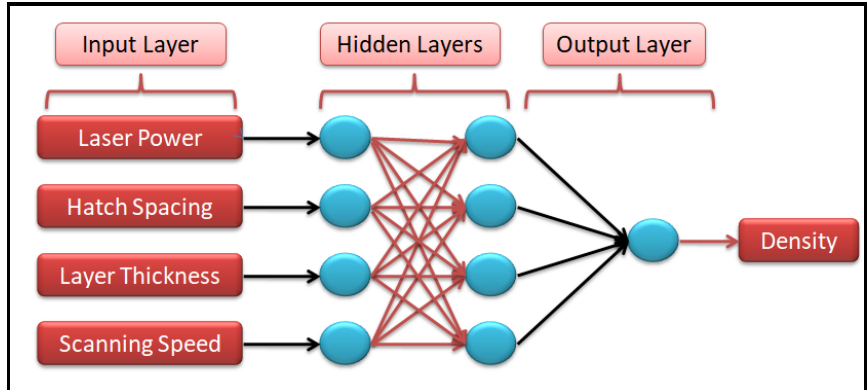
Figure 3. Diagram of ANN model.